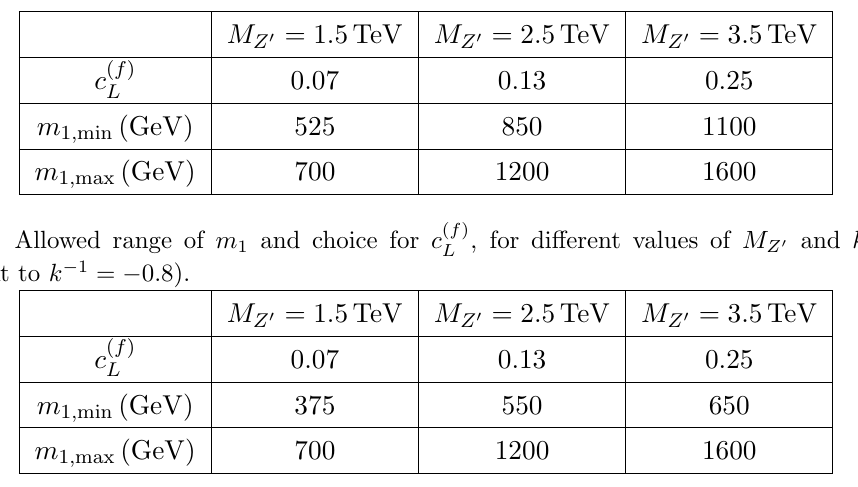
( f ) , for di(cid:11)erent values of M Z 0 and k = 0 (equivalent 1 and choice for c L